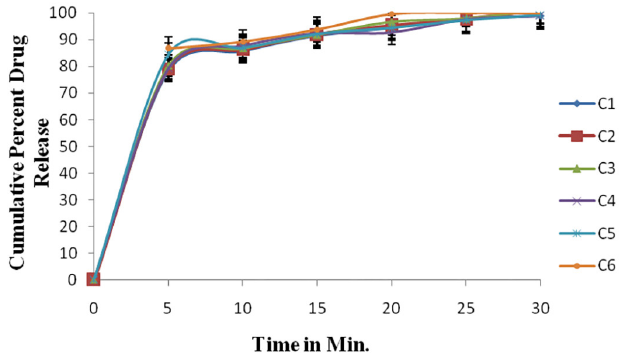
FIGURE 3 - Effect of different Superdisintegrant Sodium starch glycolate(C1 & C2), cross carmellose sodium (C3 & C4) and crospovidone (C5 & C6)in different concentration (5% & 7.5%) on in vitro release of granisetron hydrochloride (n = 3, mean ± SD).